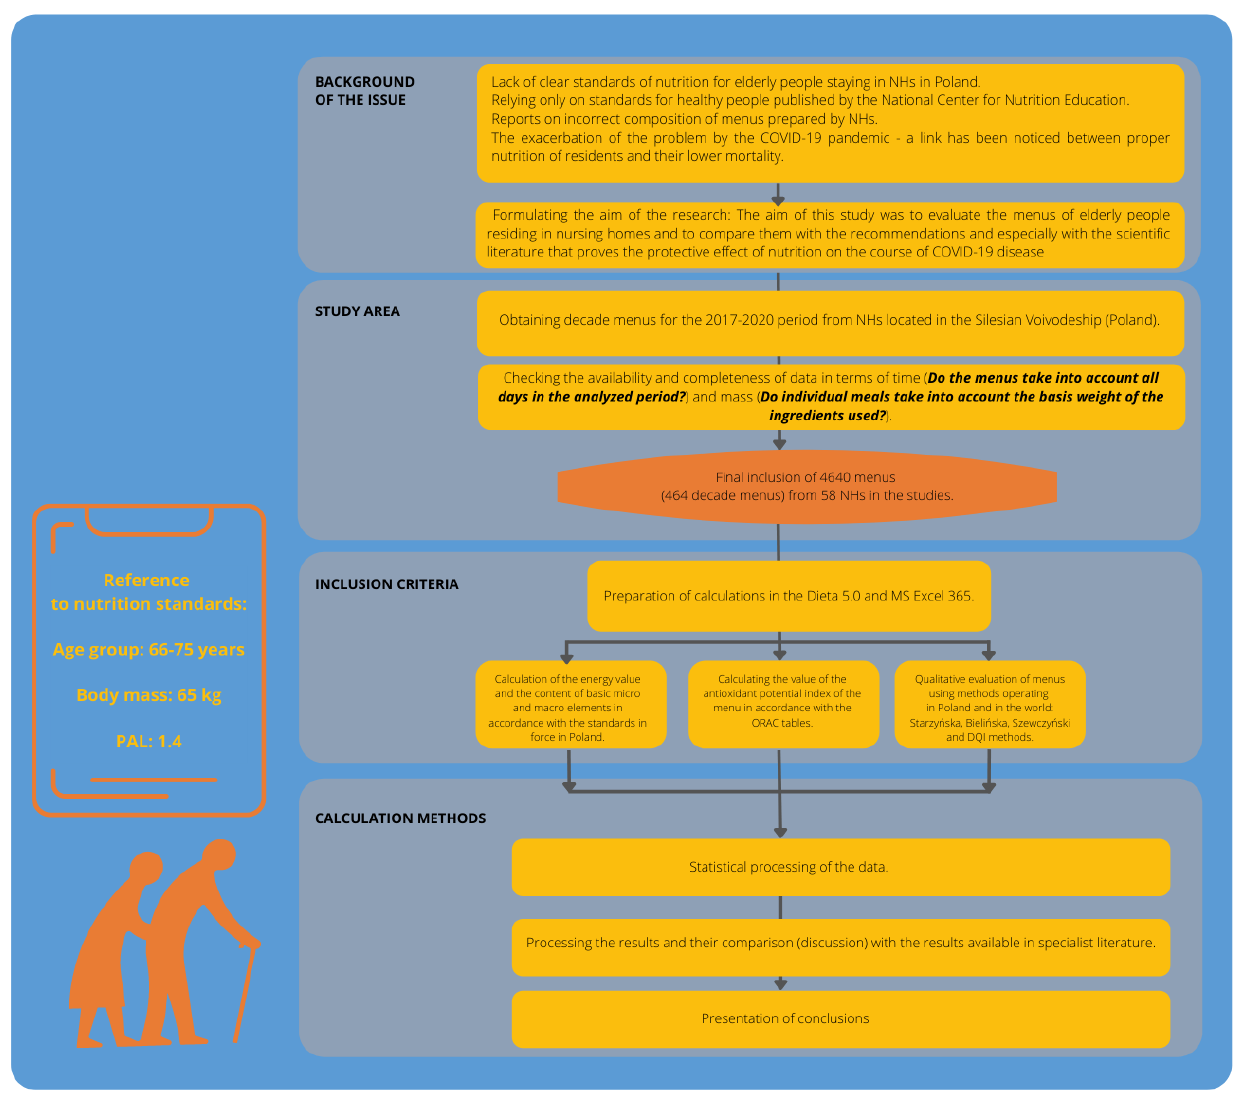
Figure 1. Publication search algorithm.